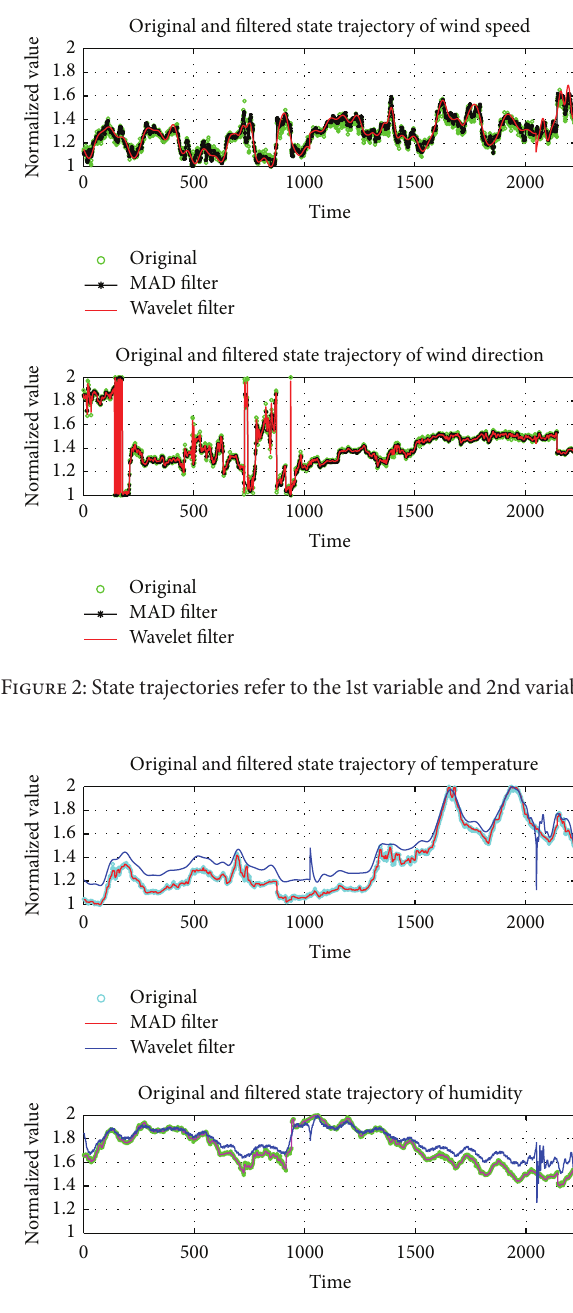
AWS and power based on the discussion in Section